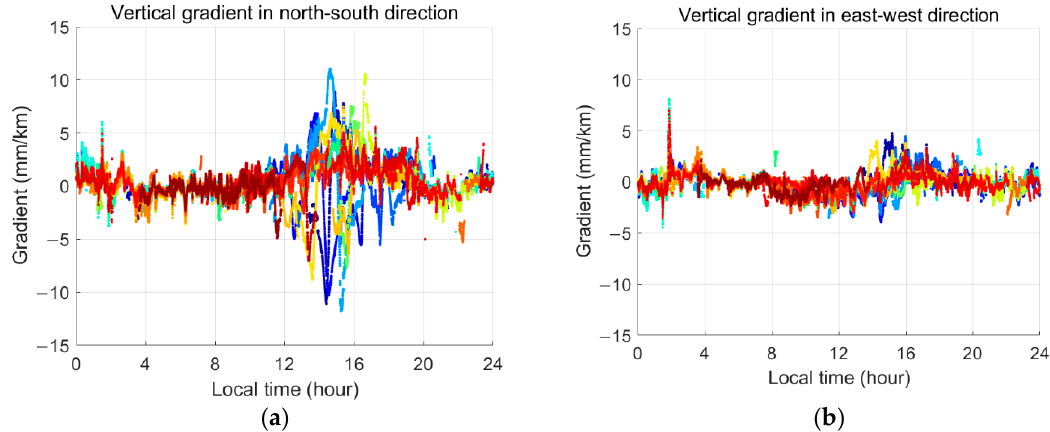
Figure 3. Vertical ionospheric gradient on global positioning system (GPS) L1 in ( a ) north–south and ( b ) east–west directions in Hong Kong on 13 March 2021.